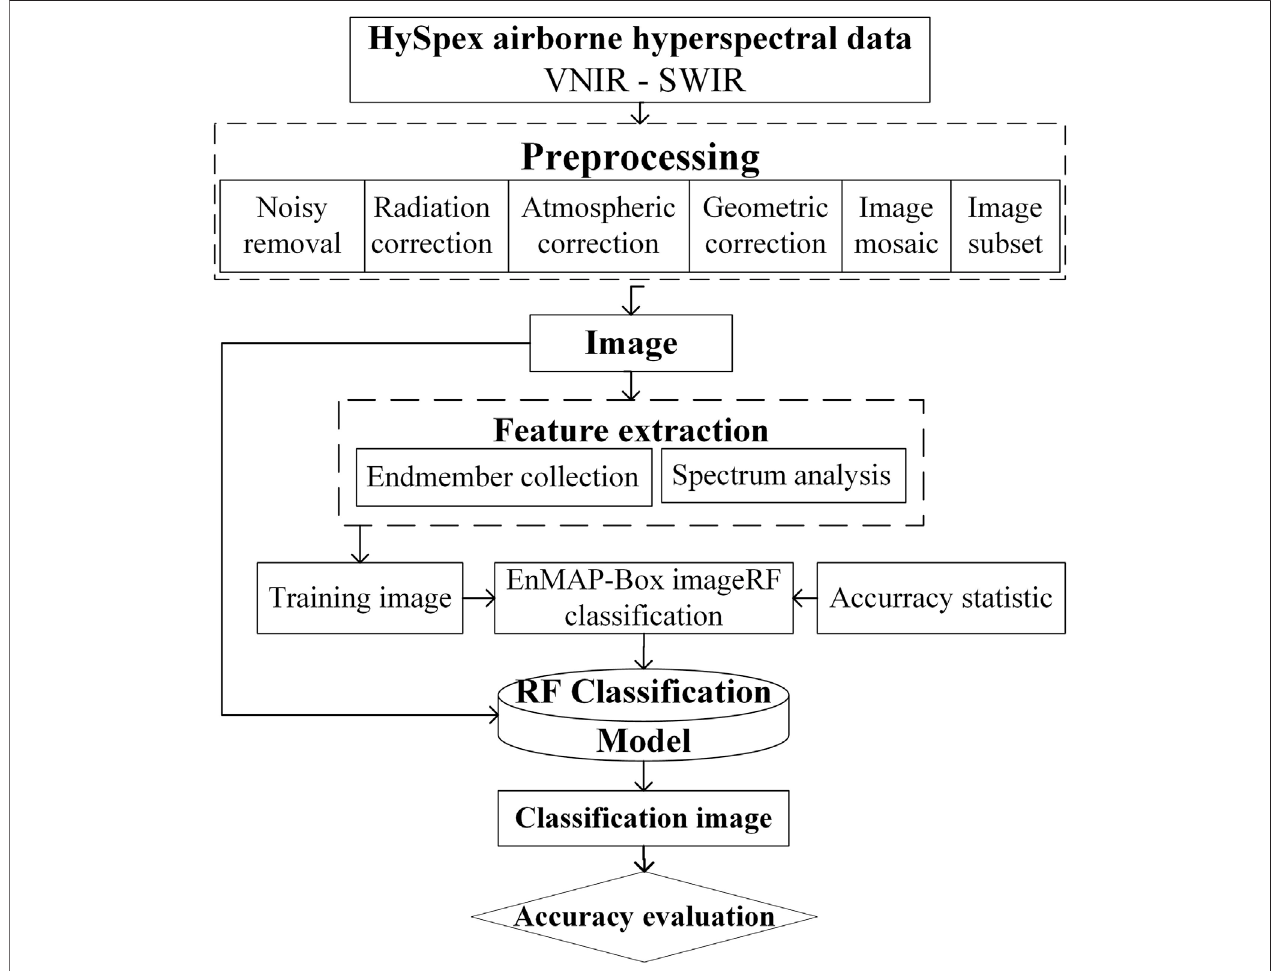
FIGURE 3 | Work fl ow of HySpex data